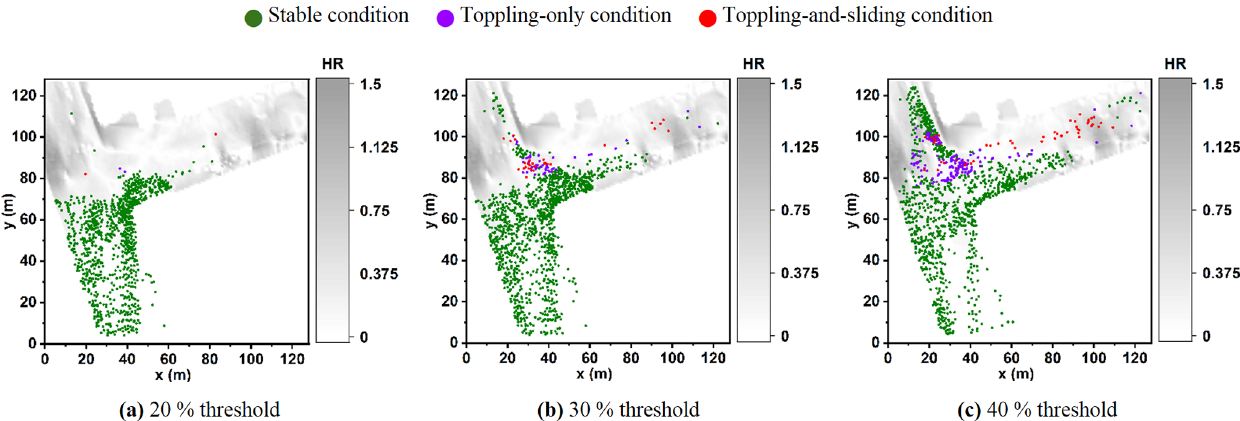
Figure 14. The spatial distribution of pedestrians over the walkable area under the predicted stability states (coloured dots) along with the HR flood map (grey shade) at simulation time t = 22min, when the number of pedestrians over the walkable area is highest after all of them had vacated the stadium: (a) 20% threshold, (b) 30% threshold, and (c) 40%